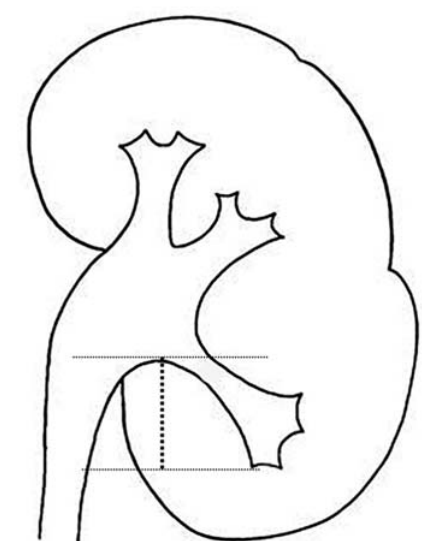
Figure 1 – Infundibular width (mm), measured as the narrowest point in the axis of the lower infundibulum.